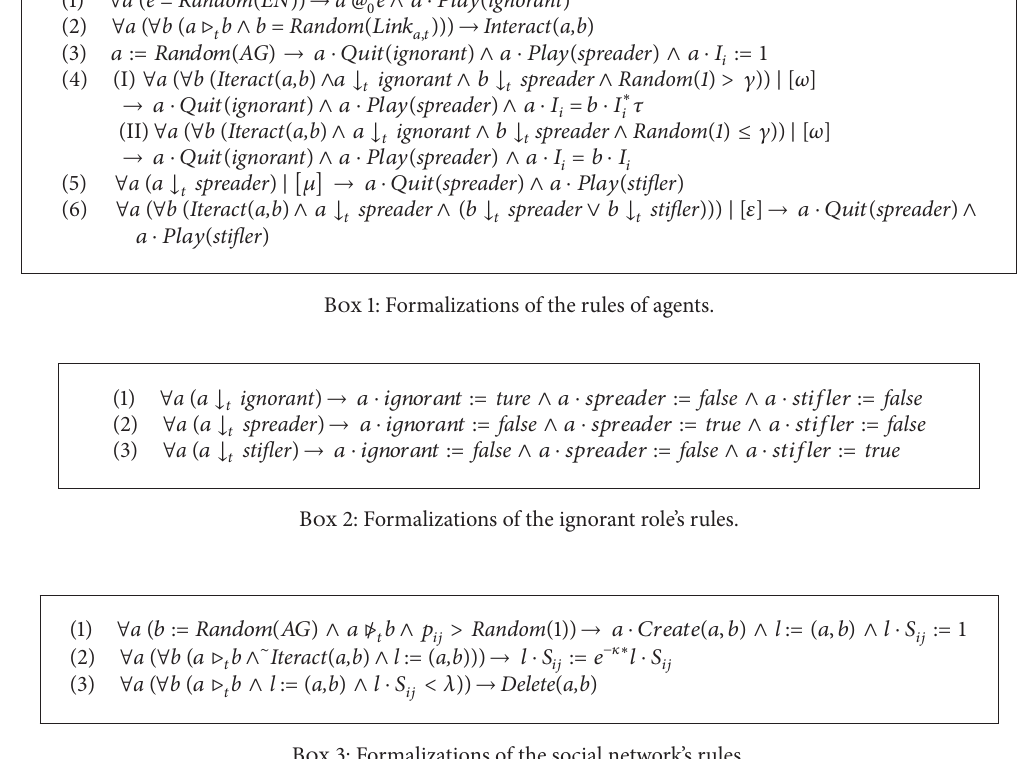
Box 3: Formalizations of the social network’s